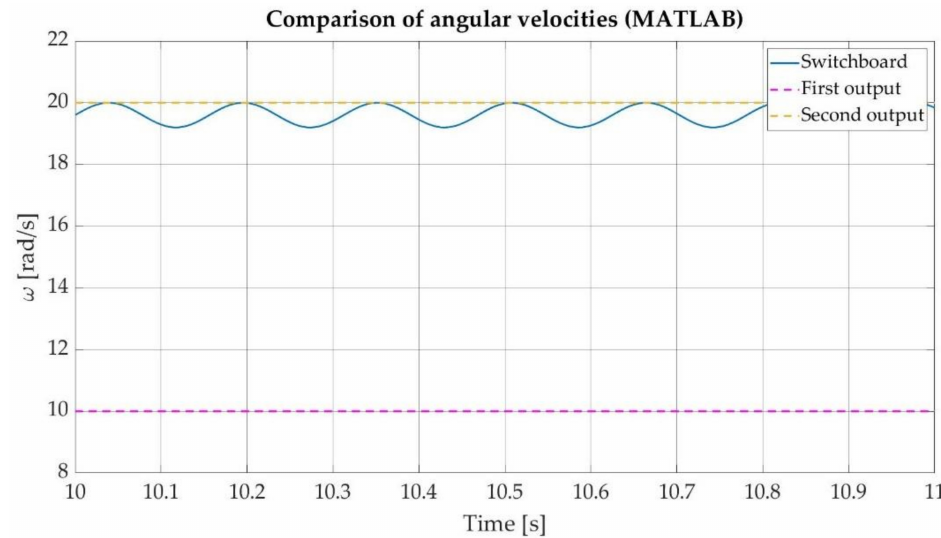
Figure 13. Comparison of the angular velocities of the first output, second output, and switchboard— results from